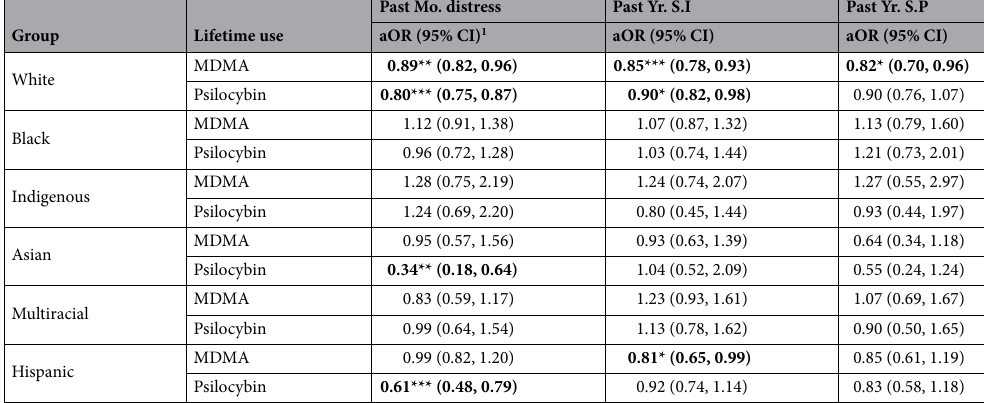
Table 3. Associations between lifetime MDMA use and psilocybin use and past month psychological distress, past year suicidal ideation (S.I.), and past year suicidal planning (S.P), by race and ethnicity. Significant values that indicate lowered odds of distress or suicidality are in bold. All aforementioned demographic factors and lifetime use variables are included as covariates. 1 *p < 0.05; **p < 0.01; ***p < 0.001; aOR, adjusted odds ratio; CI, confidence